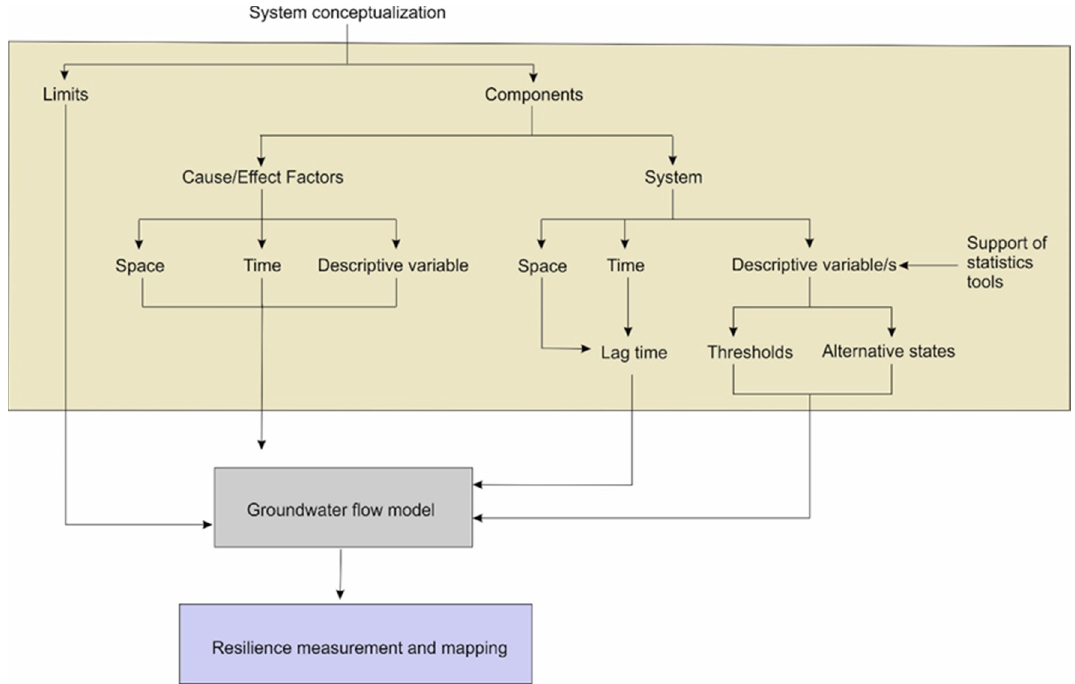
Figure 1. Flowchart of conceptual, operational and methodological considerations when applied to the aquifer resilience approach. The procedure has three phases: the first one, in beige, describes the data treatment and definition of key variables; the second one, in grey, the groundwater flow model; and the third one, in purple, the resilience measurement and mapping.